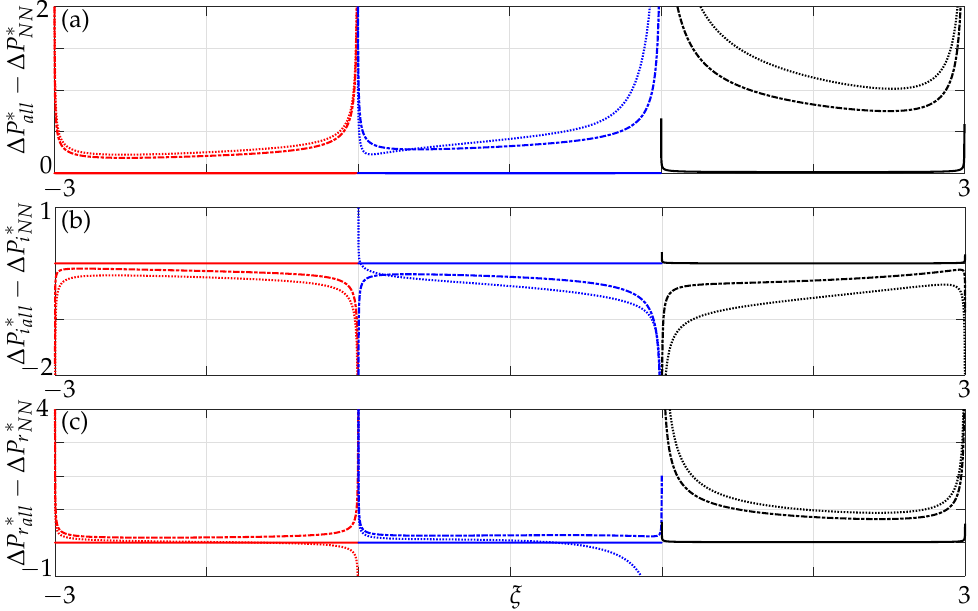
Figure 10. Difference in ( a ) absolute, ( b ) imaginary and ( c ) real values of nondimensional pressure difference across three beams incorporating all members and when only nearest neighbours are incorporated at Re = 1; solid lines: ¯ g = 8, dash-dotted lines: ¯ g = 0.4, dotted lines: ¯ g = 0.1, with the left-most beam active and the rest